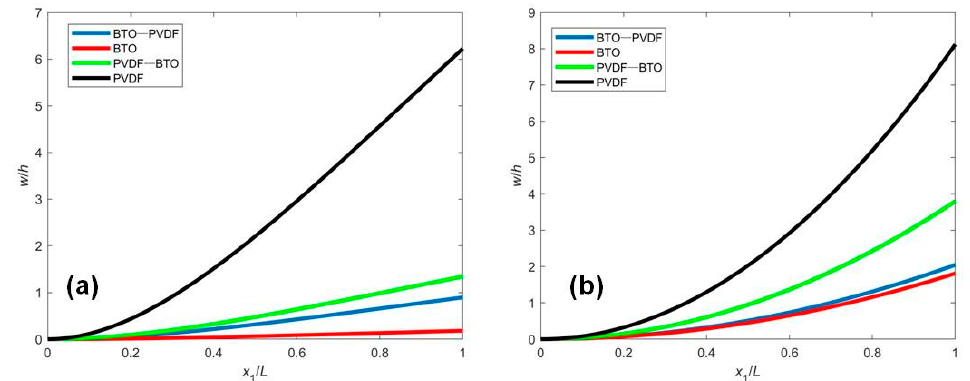
Figure 2. The normalized deflection w / h of FGM piezoelectric cantilever nanobeam subjected to ( a ) mechanical loading q = 0.01 nN / nm , V 0 = 0 and ( b ) electrical loading V 0 = − 1 V , q =